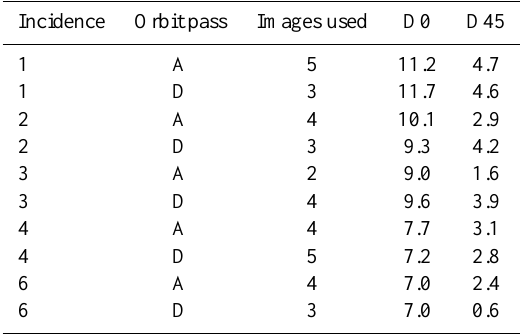
Fig. 9. σ 0 HH to biomass water content scatterplot at the agricul- Figure 9.  0 HH to biomass water content scatterplot at the agricultural season beginning for fields tural season beginning for fields with North-South row orientations with North-South row orientations (ASAR image acquired the 01/01/2008, in ascending orbit, and (ASAR image acquired the 01/01/2008, in ascending orbit, and in- incidence angle 1). cidence angle